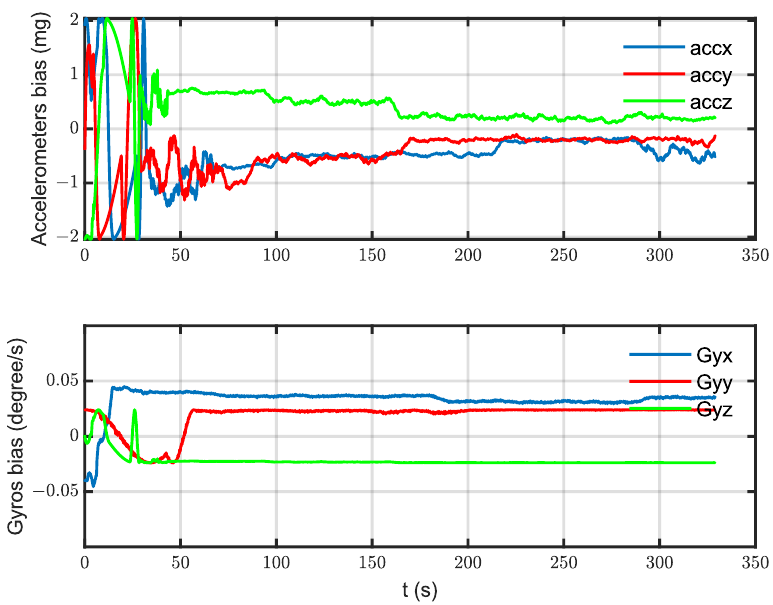
Figure 11. The estimated bias for the 6 sensors: 3 for the gyros and 3 for the